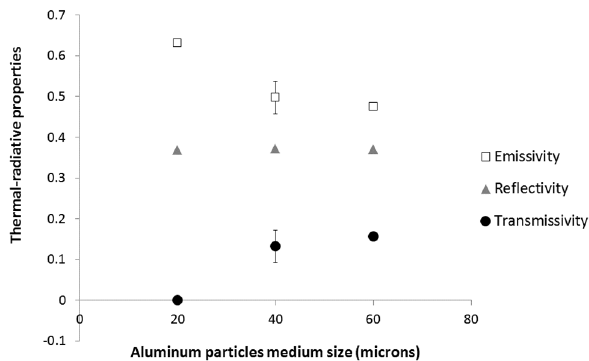
Figure 5. Effect of aluminum particles medium size on emissivity, reflectivity and transmissivity of 5A20, 5A40 and 5A60 coatings.